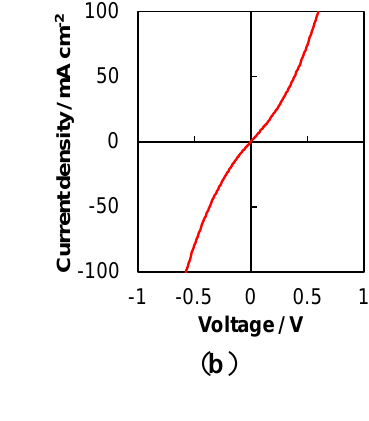
Figure 24. Organic/organic ohmic n + p + -homojunction ( a ) and its current-voltage characteristics ( b